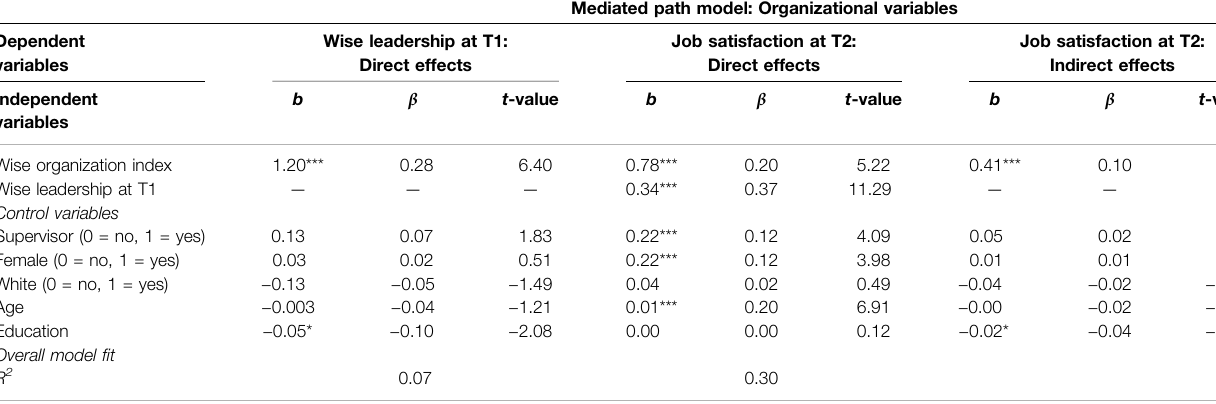
TABLE 5B | Direct and indirect effects of mediated path model — employee well-being variables at T2. Dependent variables